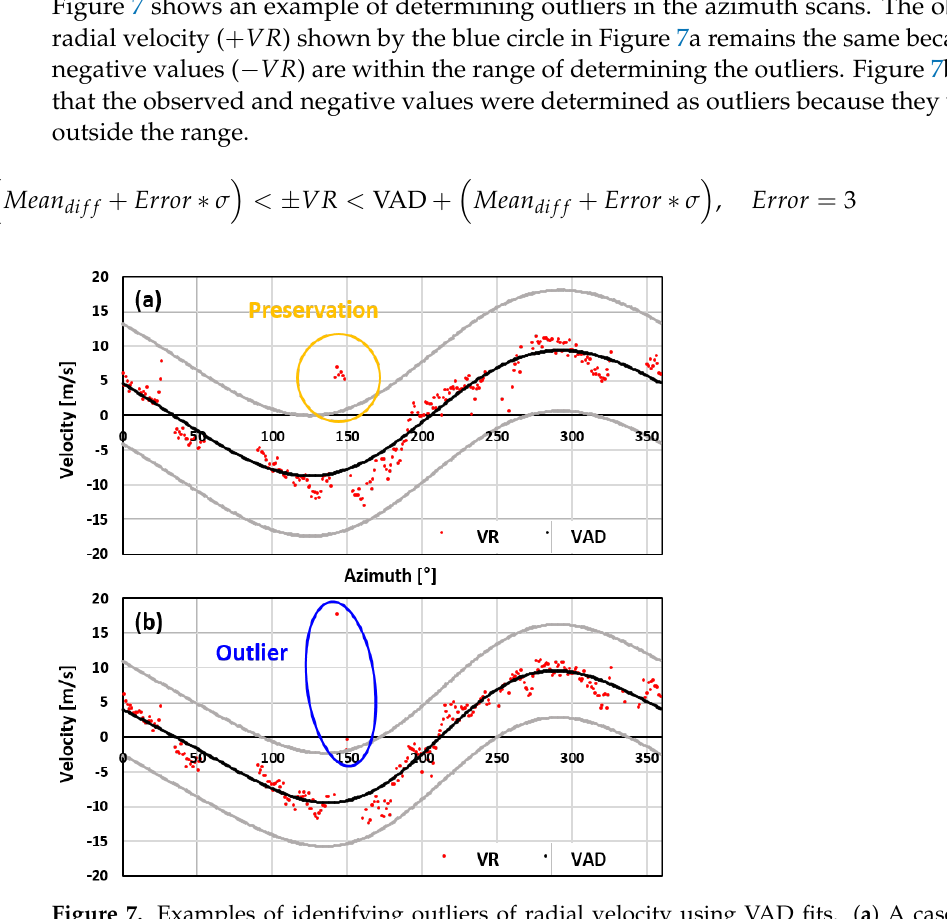
Figure 7. Examples of identifying outliers of radial velocity using VAD fits. ( a ) A case for not an outlier (in the orange circle). ( b ) A case for an outlier (in the blue circle). The red dots indicate individual radial velocities. The black and gray lines represent the VAD and error curves, respectively.